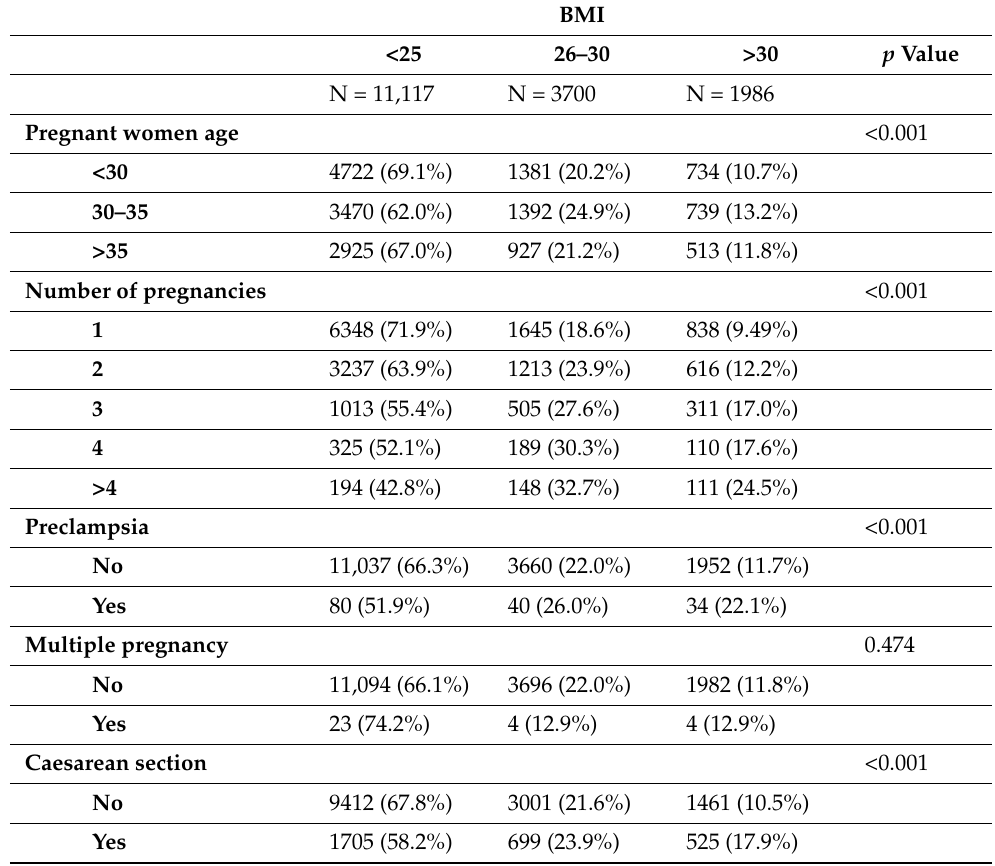
Table 3. Pregnant women characteristics by body mass index